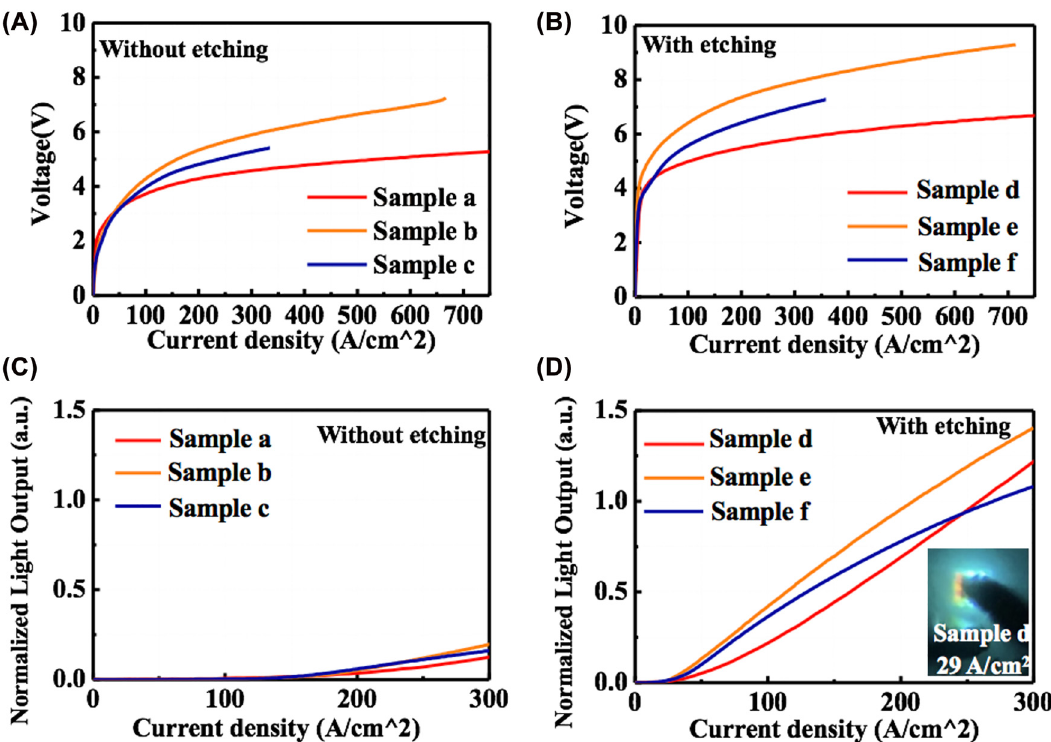
Figure 7: I – V characteristics in the samples (A) without and (B) with etching as a function of effective current density. Normalized light outputs of (C) samples (a, b, and c) without etching and (D) truncated samples (a, b, and c), while the range of current density is set to 0–300 A/cm 2 . The inset photo shows the emission of sample d under the current injection of 29 A/cm 2 .